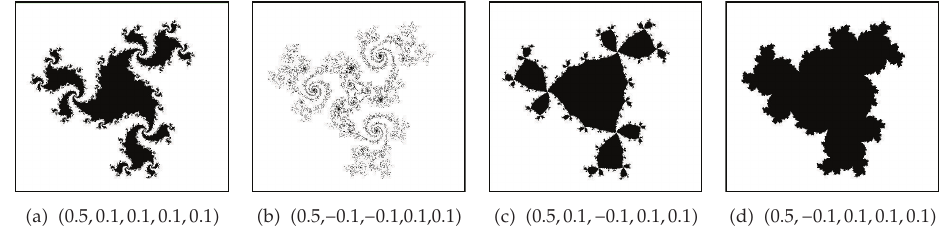
Figure 19: The generalized J sets perturbed by the composing noise when α (cid:6) 3 and c (cid:6) 0 . 5 − 0 . 5 i .